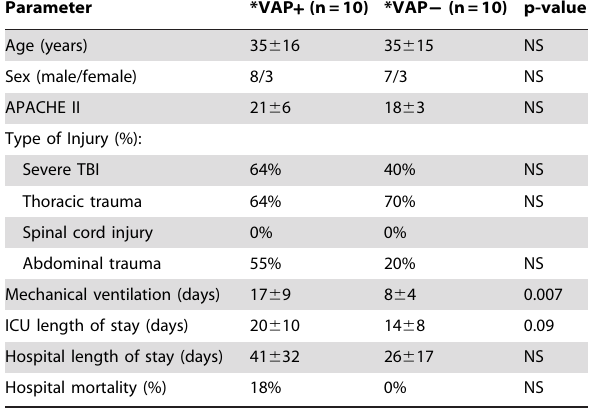
Table 1. Patient Demographics.